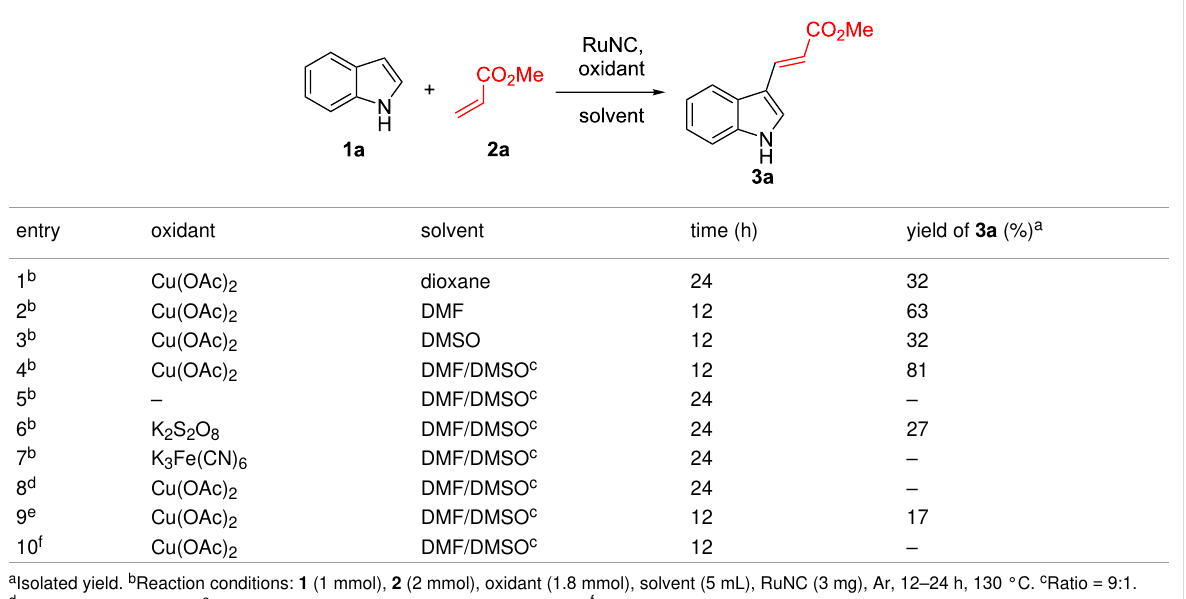
Table 1: Control experiments and optimisation of the conditions for the alkenylation of indole ( 1a ).